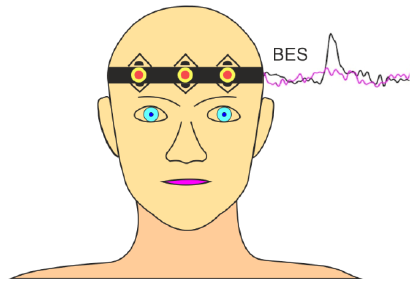
Figure 5. Headband with placed plates and BESs sensors on the forehead.